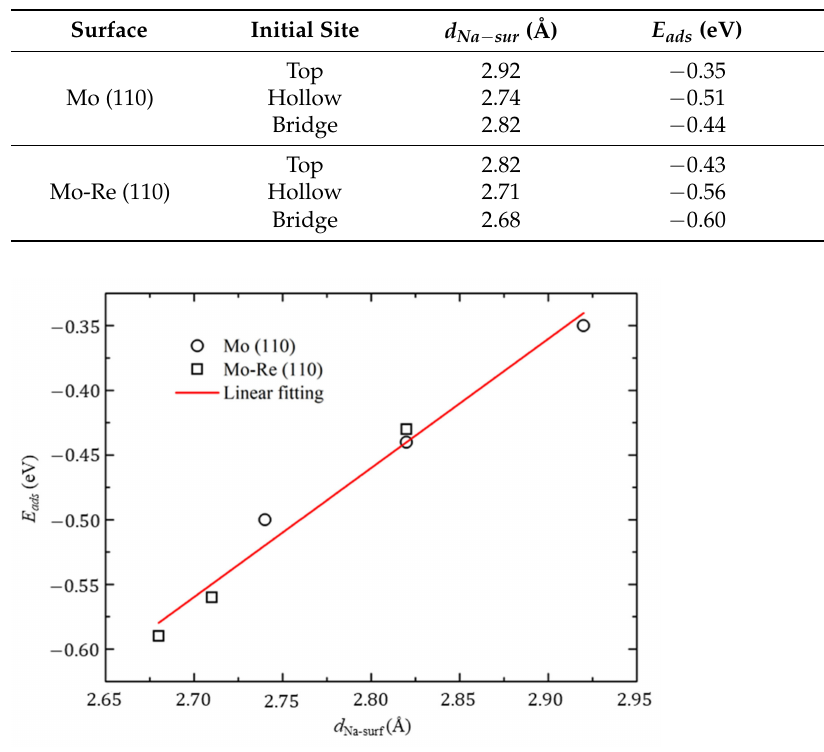
Table 2. Adsorption energy of Na on Mo (110) and Mo-Re (110) surfaces. E ads is the adsorption energy, and d Na − surf is the vertical distance between the adsorbate and the top layer of the slab model.